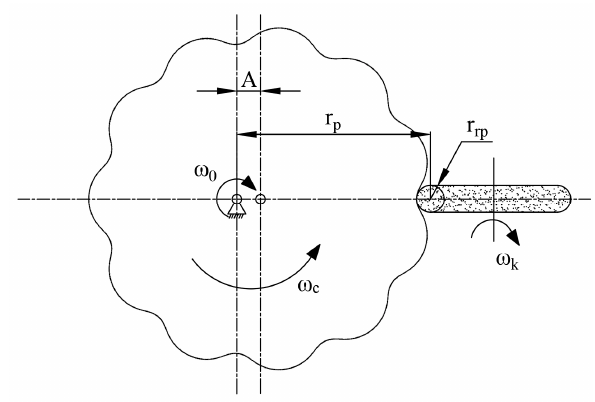
Figure 3. Schematic diagram of the generation method.